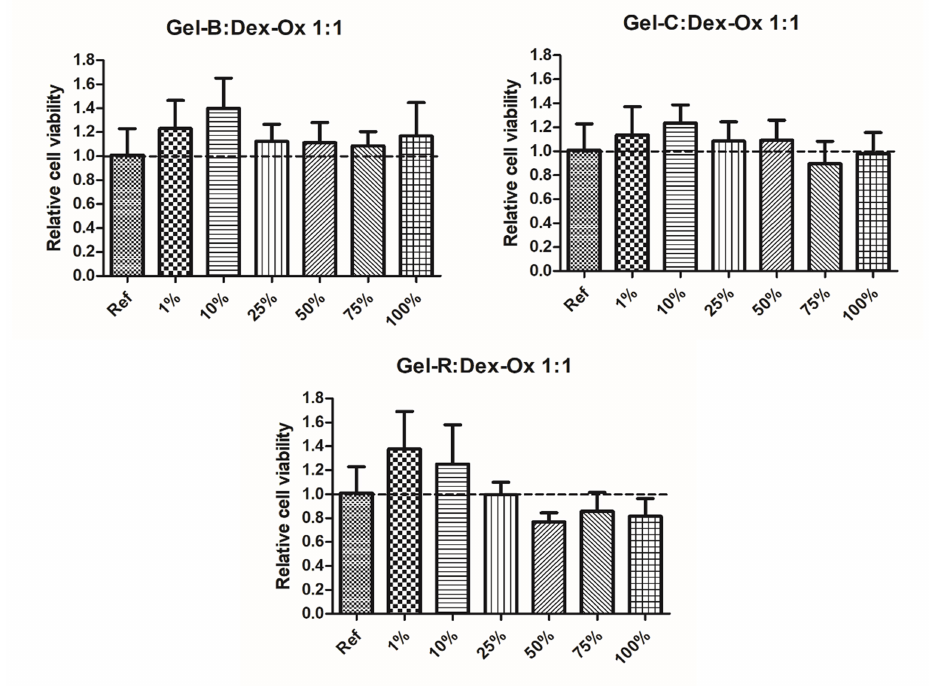
Figure 5. Cell viability determined by ATP assay performed on extracts from Gel:Dex-Ox 1:1